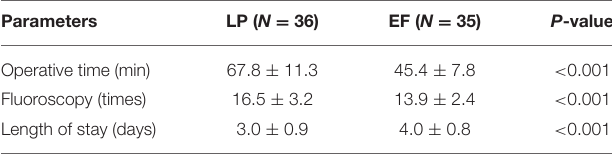
TABLE 2 | Operative parameters for fracture surgery.